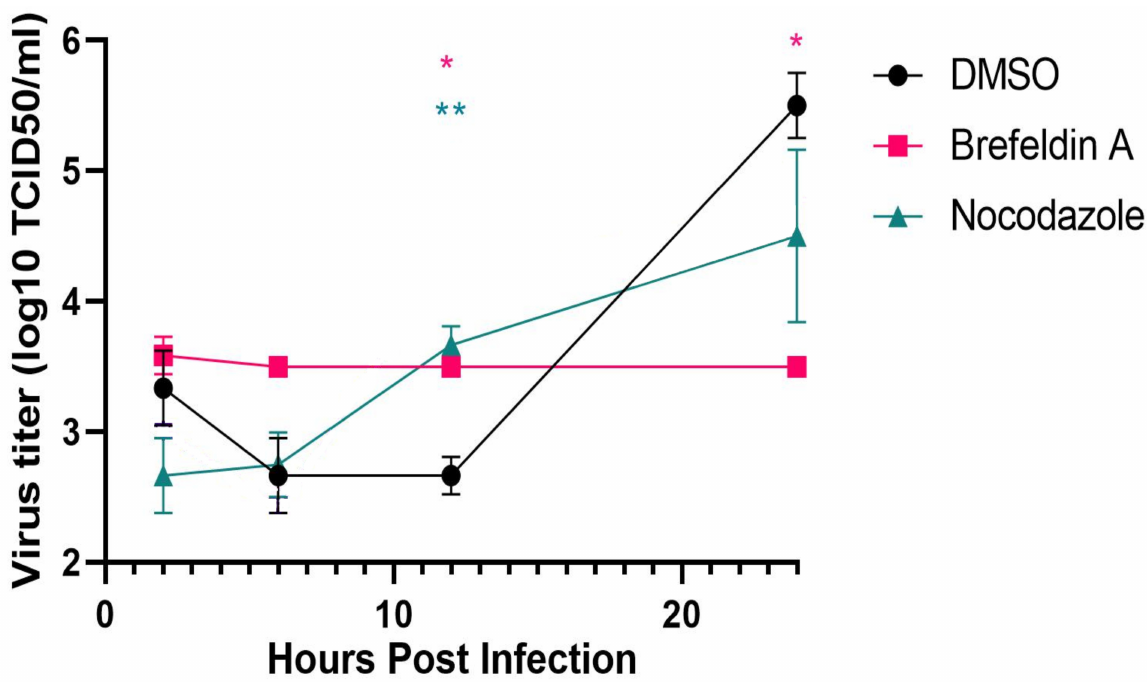
Figure 11. Effects of Golgi fragmentation induced by the inhibitors brefeldin A or nocodazole on SARS-CoV-2 replication. Vero E6 cells were infected with SARS-CoV-2 at 0 h and the brefeldin A (10 µ M final), nocodazole (10 µ g/mL), or DMSO carrier (0.4 µ l/mL) added at 2 h post infection. Supernatants were collected at 2, 6, 12 and 24 h post-infection and titered by end-point dilution. Note: * p < 0.05 DMSO: Brefeldin A in pink and ** p < 0.01 DMSO: Nocodazole in